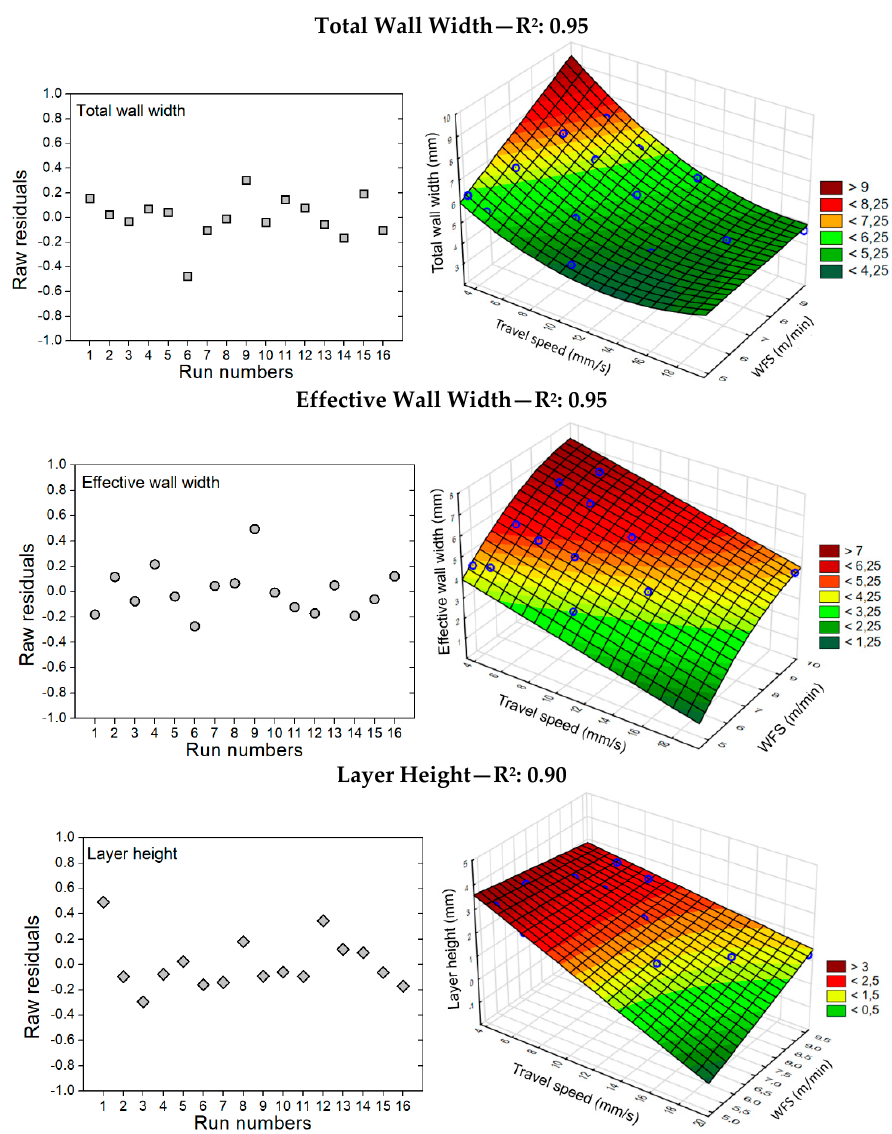
Figure 18. Summary of the multivariate regression performed for the TWW, EWW, and LH responses: R 2 values, residual plots, response surfaces, and regression equations.